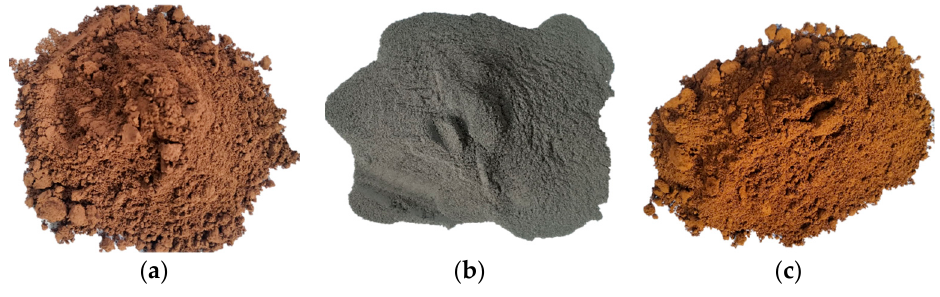
Figure 4. RM ( a ), GGBFS ( b ), and EAFD ( c ) powders. The mortar mix proportion was designed by the volumetric method of ACI 211.1